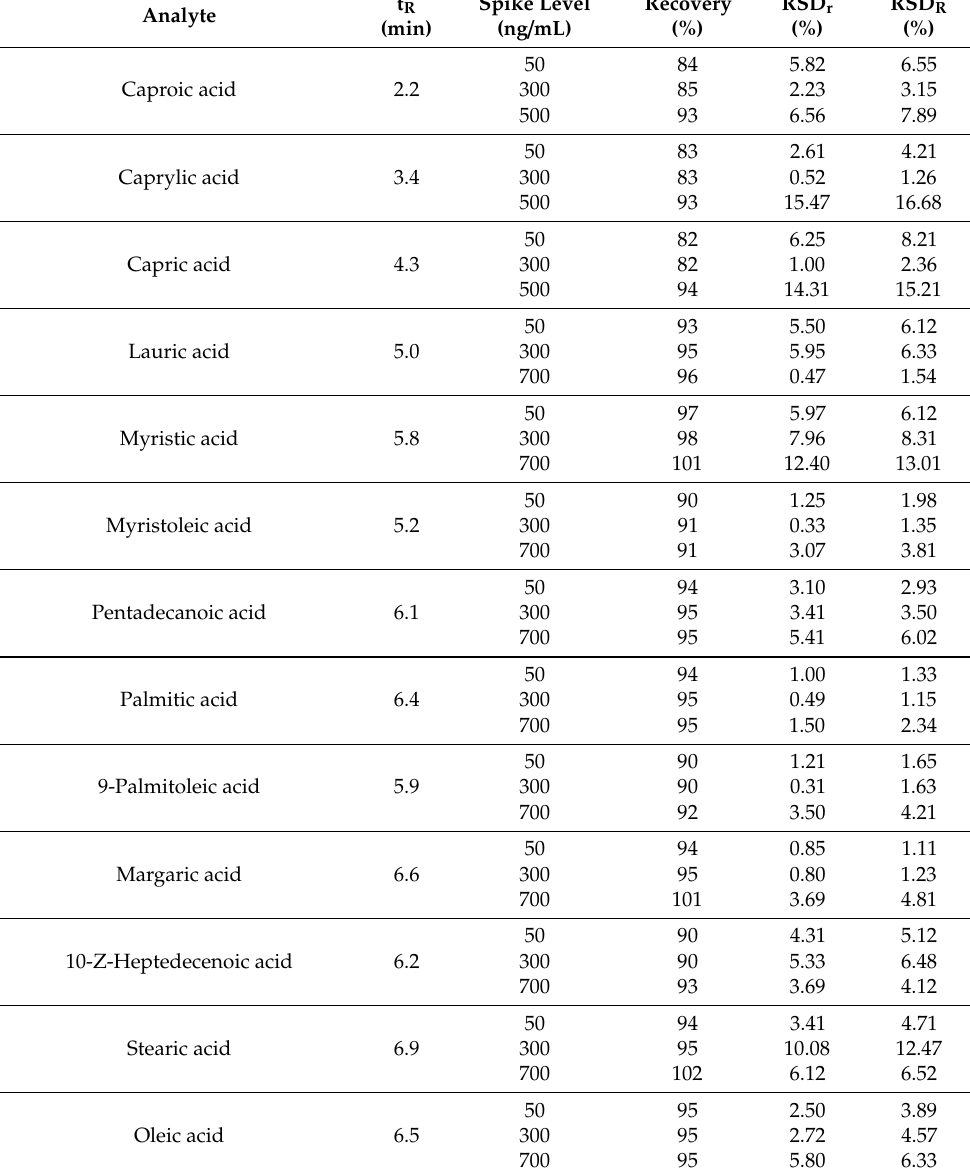
Table 3. Accuracy (recovery %) and precision data (RSD %) in spiked milk